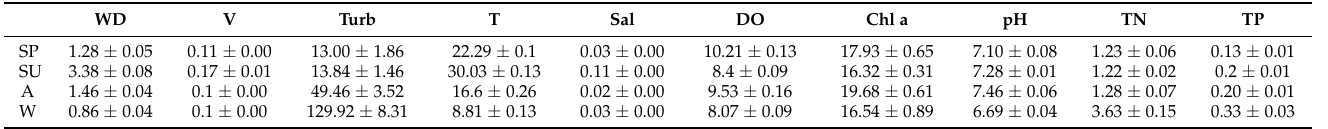
Table A3. The seasonal environment